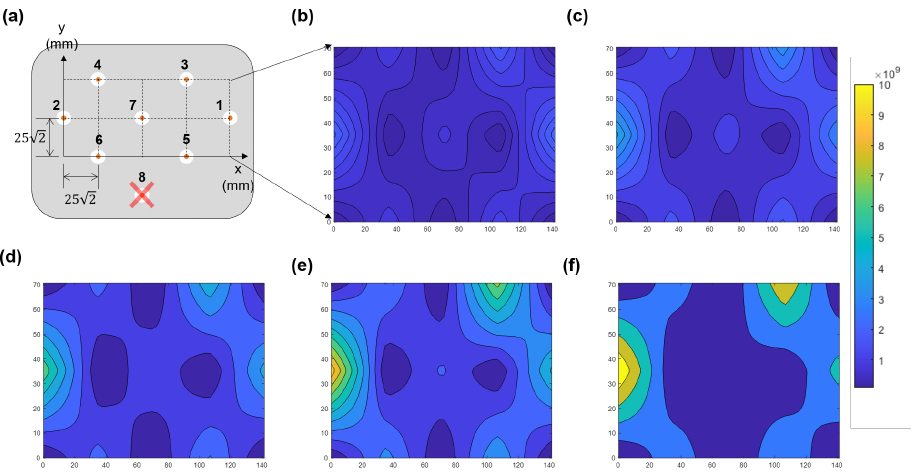
Figure 8. ( a ) Two-dimensional Cartesian coordinate and the antenna positions and numbers of the √ TUSI probe; the grid distance is 25 2 mm and inter-diagonal distance is 50 mm. Measured electron density distribution at the RF power of ( b ) 100 W, ( c ) 150 W, ( d ) 200 W, ( e ) 250 W, and ( f ) 300 W with the same z-scale from 10 8 cm − 3 to 2 × 10 10 cm − 3 . For clear visualization, the 2-dimensional linear-interpolation method with 50 intervals are adopted in ( b – f ). The RF8 malfunctions, so it is